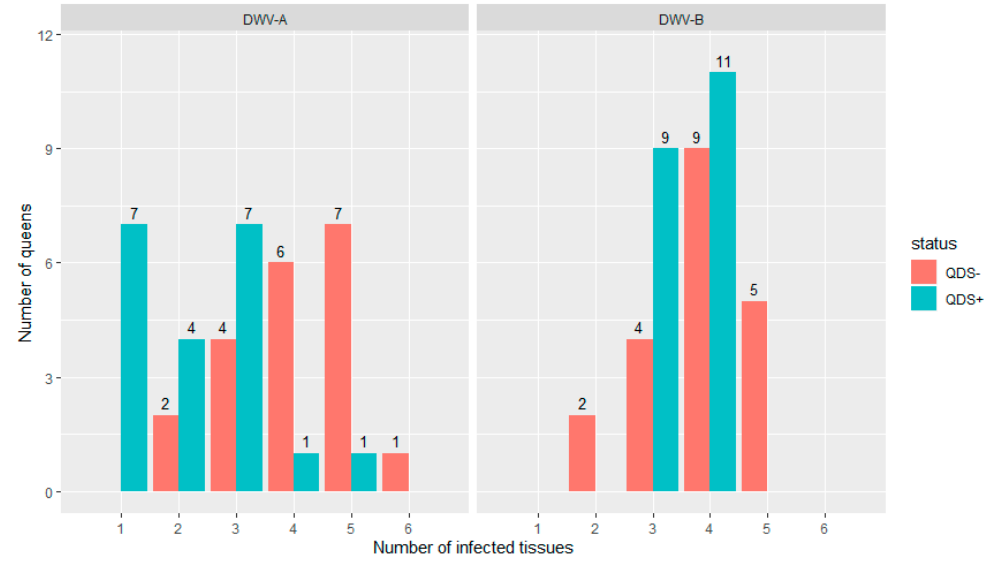
Figure 1. Distribution of the number of infected tissues in each queen for both DWV-A and DWV-B. Data is presented for queens descending from SOV-positive (QDS+, marked in green) and SOV-negative (QDS – , marked in red) queens. Queens descending from SOV+ colonies have a significantly lower number of infected tissues for DWV-A.